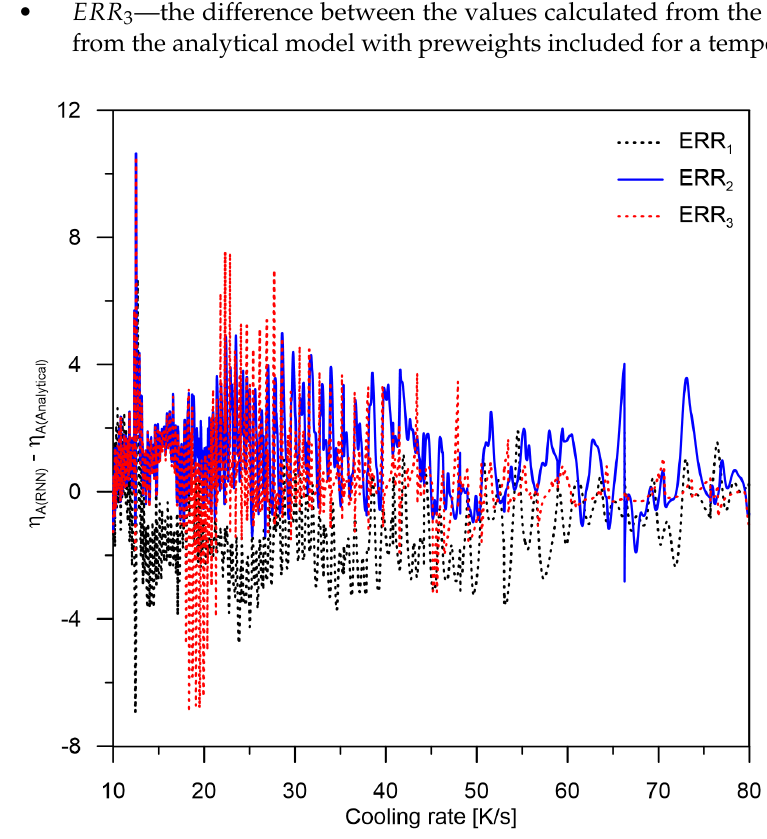
Figure 13. Visualization of the difference η A ( RNN ) − η A ( Analytical ) for a cooling rate range of 10–80 K/s. Table 4. Summary of error values (residual austenite) according to Equation